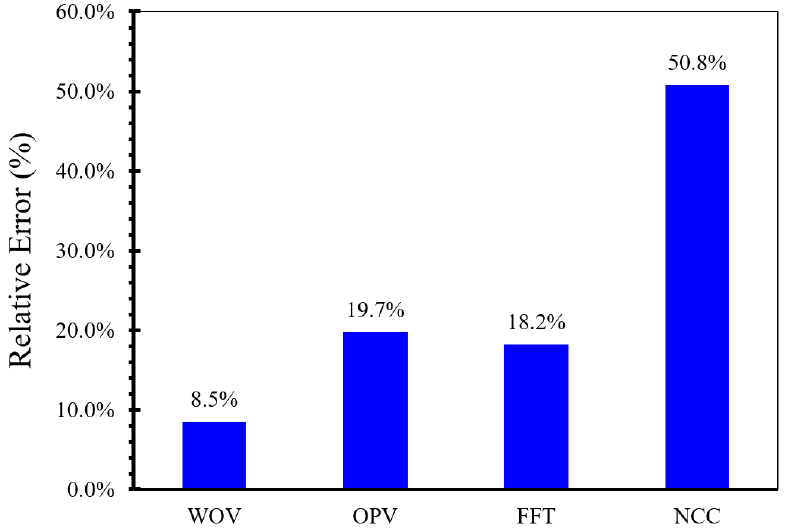
Figure 7. Comparison between in-situ optical velocimetries.